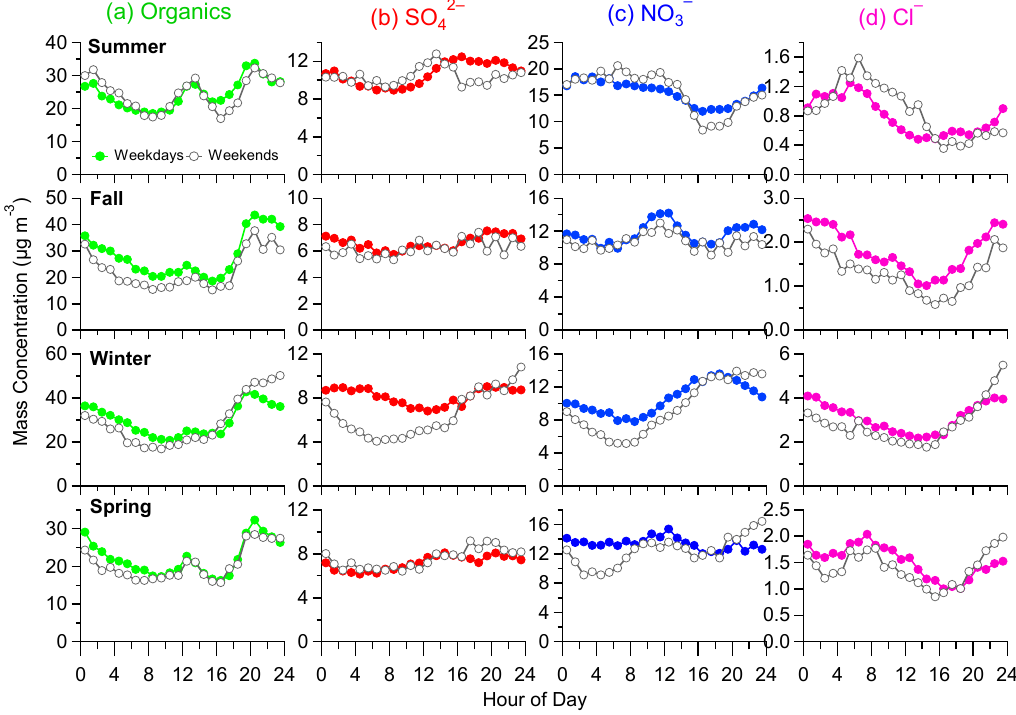
Figure 8. Comparison of the average diurnal cycles of (a) organics, (b) SO 2 − during the four seasons. Note that the periods with NR-PM 1 < 20µgm − 3 are